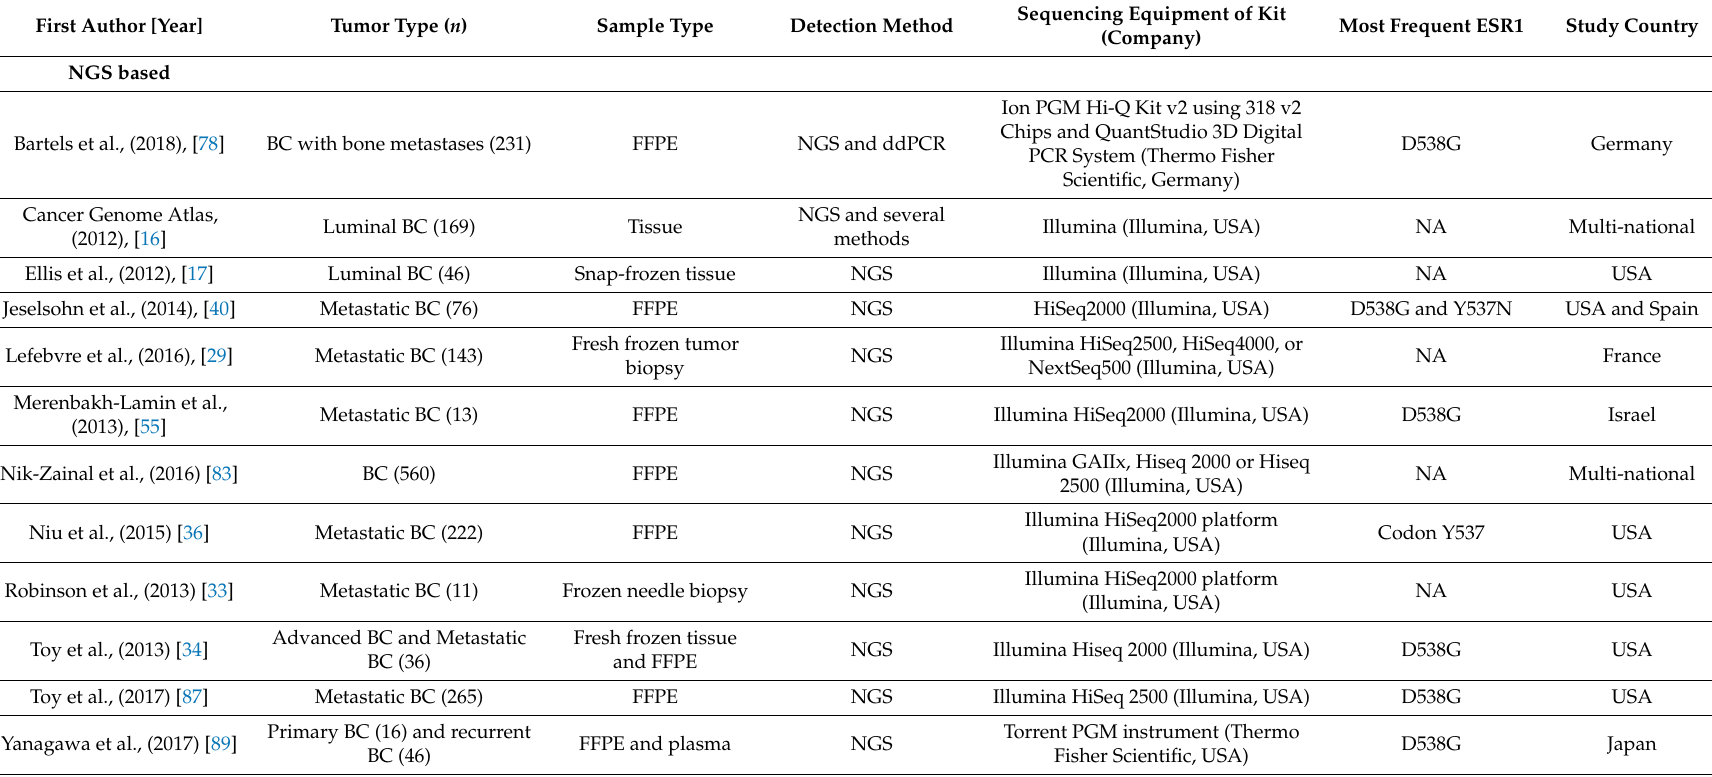
Table 1. Molecular assays and main characteristics of the studies for advanced breast cancer with ESR1